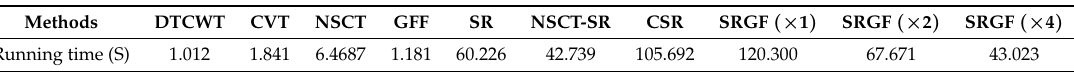
Table 6. Average running time for all the test images in the “Lytro” dataset ( × 1, × 2, × 4 denote the number of threads used for parallel